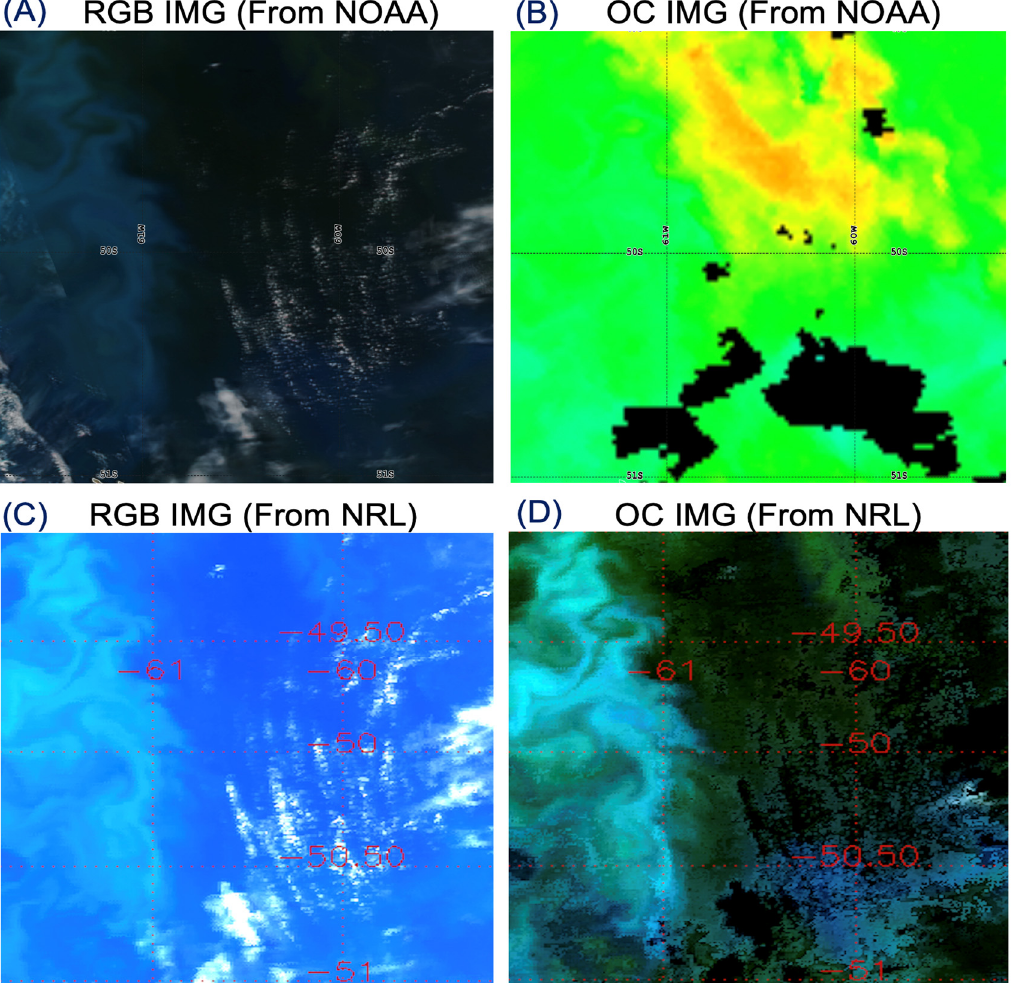
Figure 6. ( A )—a portion of NOAA-posted VIIRS RGB image off the eastern coastal area of Argentina acquired on 8 December 2017; ( B )—the NOAA-posted Chl-a image; ( C )—the RGB image we ob- tained through processing the VIIRS radiance and geolocation data sets; and ( D )—our retrieved RGB water leaving reflectance image. The spatial distribution patterns of chlorophyll blooming fea- tures are seen in ( A , C , D